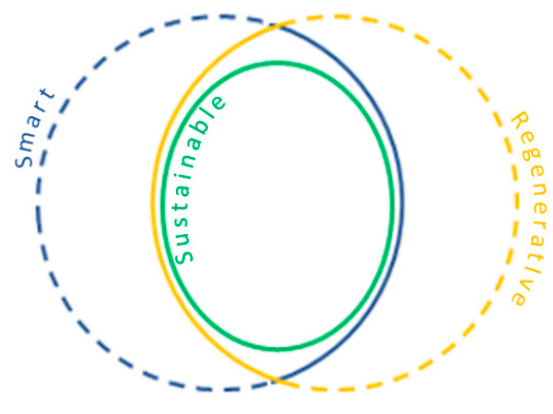
Figure 4. Cat-eye diagram of smart and sustainable urban places (blue for smart + yellow for regenerative = green for sustainable).